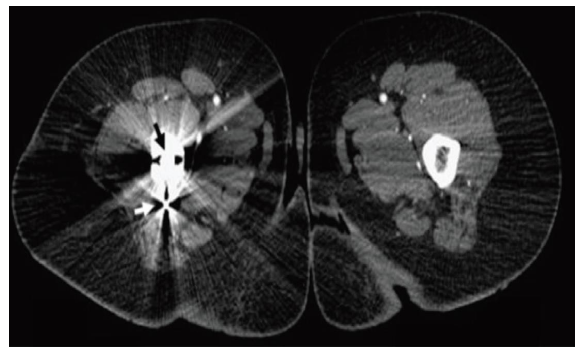
Figure 3: CT with contrast showing resolution of the pseudoa- neurysm after embolization (done after 6